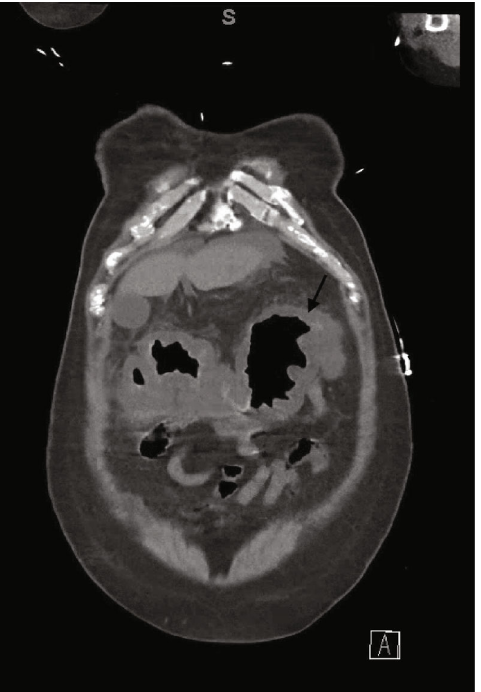
Figure 1: CT abdomen coronal view: arrow indicating thumbprinting sign indicative of colitis in a patient having coinfection with COVID-19 and Clostridium di ffi cile.